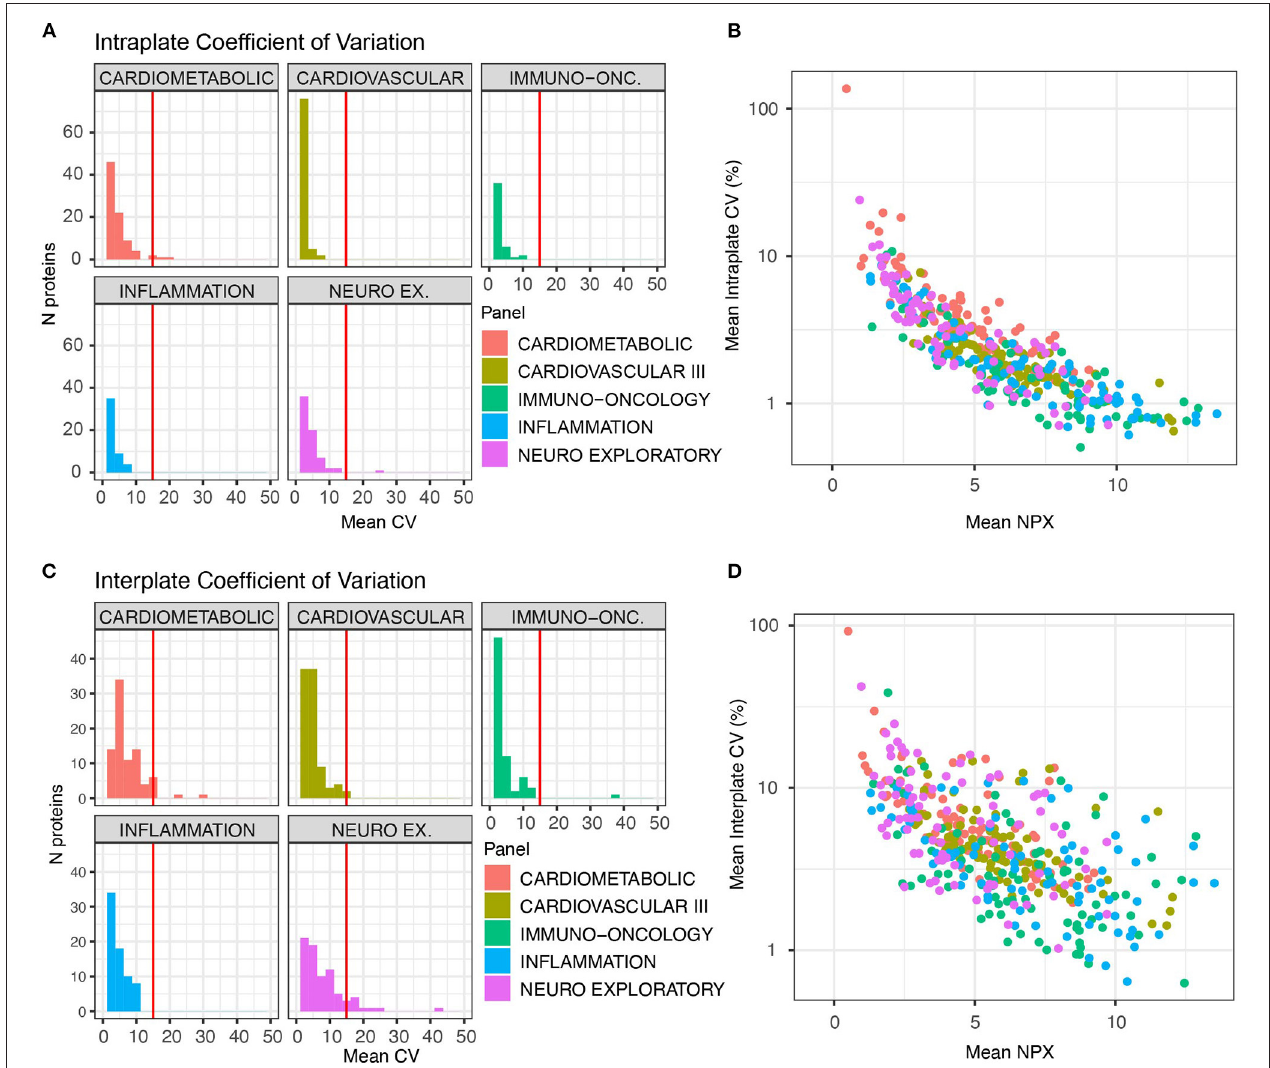
FIGURE 3 | Proteins measured on Olink panels consistently demonstrate low CVs. Three control samples were run in duplicate on each plate across all panels for independent evaluation of assay precision and replicability. Coefficient of variation (CV) calculations were used to assess measurement reliability. The threshold of acceptable CV (15%) is marked with a vertical red line. (A) Intra-plate CVs for duplicates on the same plates. (B) Intraplate CV is strongly related to absolute NPX value. (C) Inter-plate CVs are marginally higher than intra-plate CVs. (D) As with intra-plate measurements, inter-plate CVs show a strong relationship to NPX